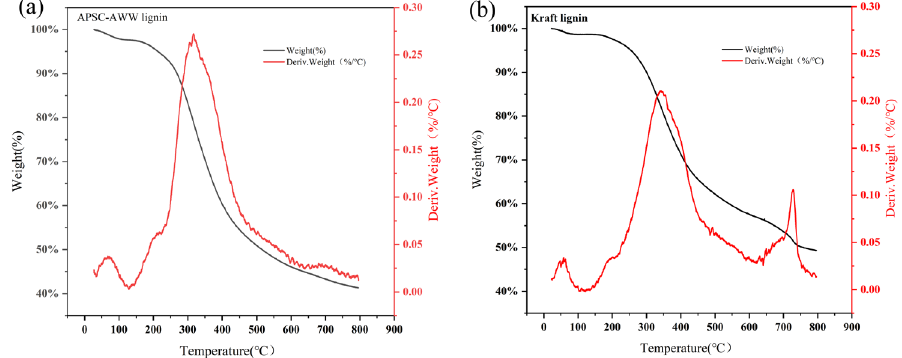
Figure 8. TGA of APSC-AWW lignin ( a ) and kraft lignin ( b